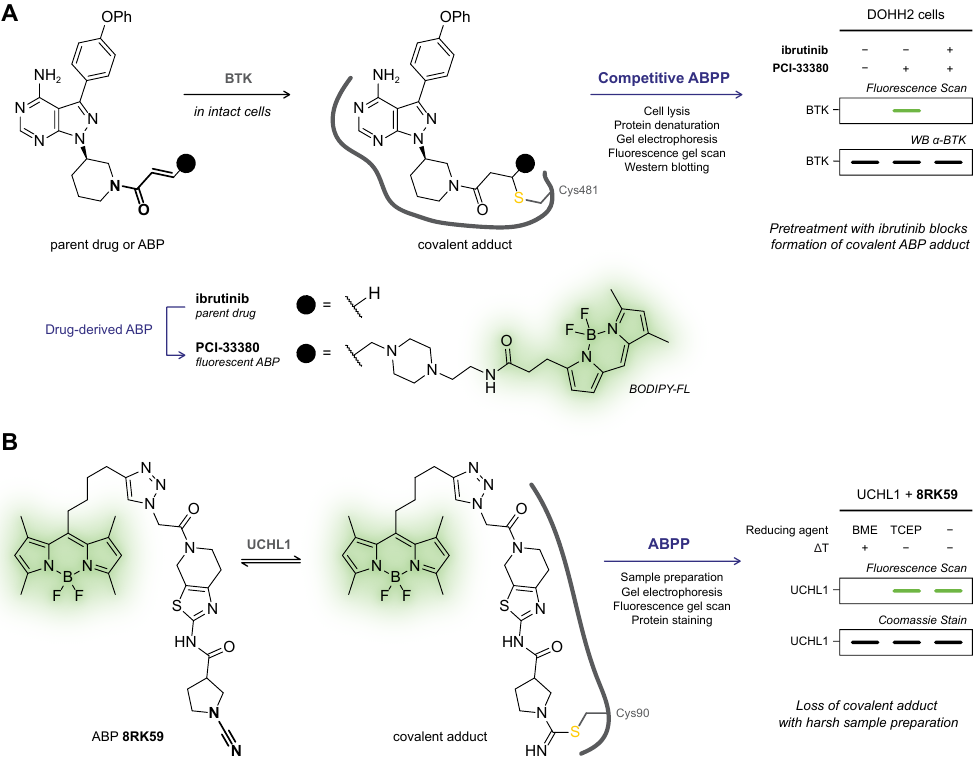
Figure 10. Gel electrophoresis platforms for covalent adduct detection with drug-derived ABPs. ( A ) Competitive ABPP. The fluorescence scan for the BODIPY-FL fluorophore reveals that BTK labeling in DOHH2 cells by cell-permeable one-step fluorescent ABP PCI-33380 is precluded by pretreatment with irreversible covalent parent inhibitor ibrutinib [11]. ( B ) The fluorescent signal originating from reversible covalent UCHL1–8RK59 adduct is not observed using harsh sample treatment prior to gel electrophoresis (boiling in presence of reducing agent BME) but can be observed using milder conditions (sample preparation in presence of reducing agent TCEP) [207]. Covalent adduct formation is validated using intact protein analysis by top-down